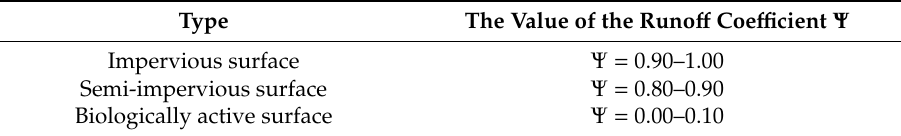
Table 1. Surface runo ff coe ffi cient in accordance with PN-EN 752. Type The Value of the Runo ff Coe ffi cient Ψ Impervious surface Ψ = 0.90–1.00 Semi-impervious surface Ψ = 0.80–0.90 Biologically active surface Ψ =